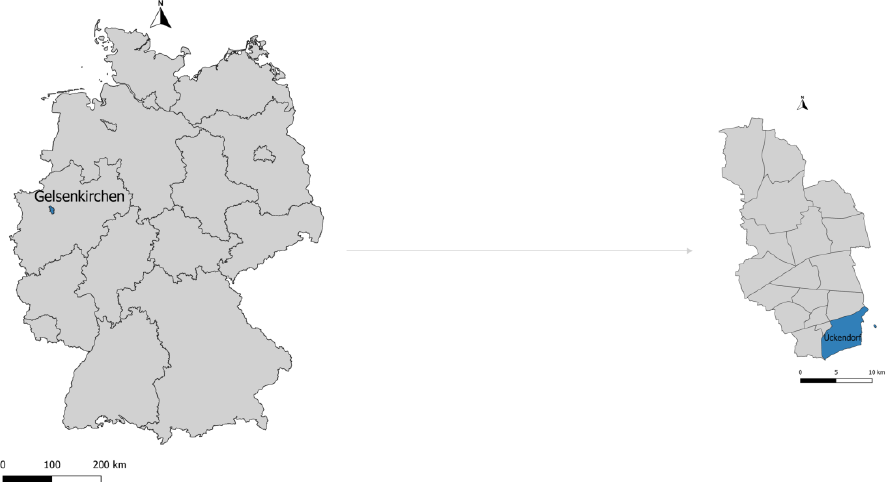
Figure 1. Location map of the study area [31,32].